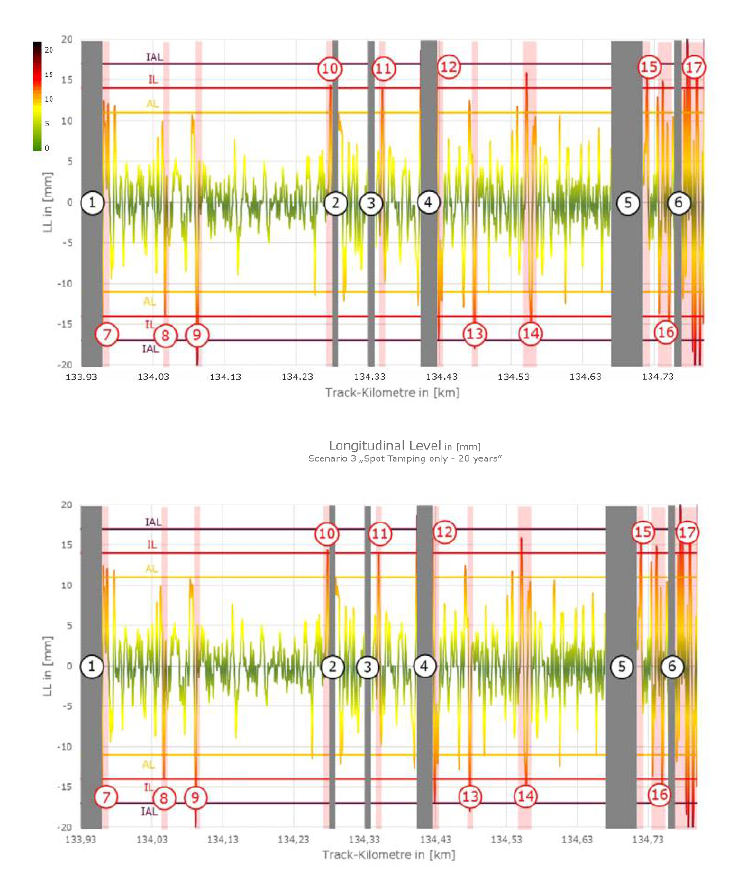
Figure 6. Showing the forecasted Longitudinal Level in 2028 (left) including the already existing Single Failures (1 to 6) and the additional ones (7 to 17) for the predicted Scenario 2a.